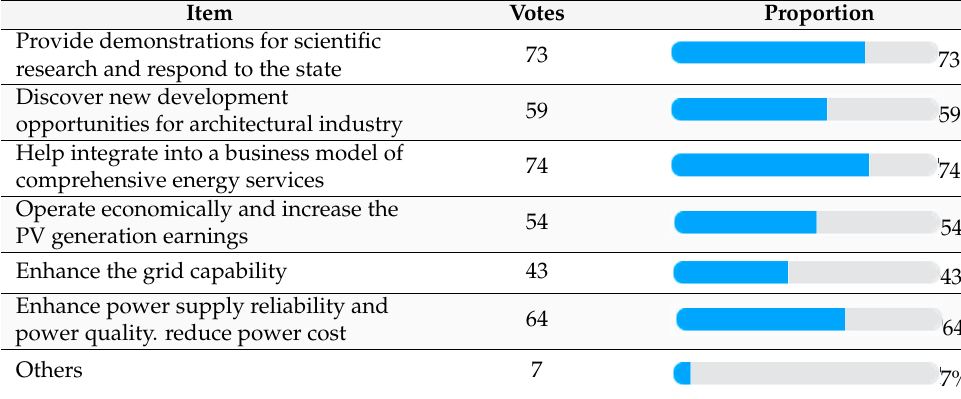
Table 2. Driving forces for developing LVDC technology.